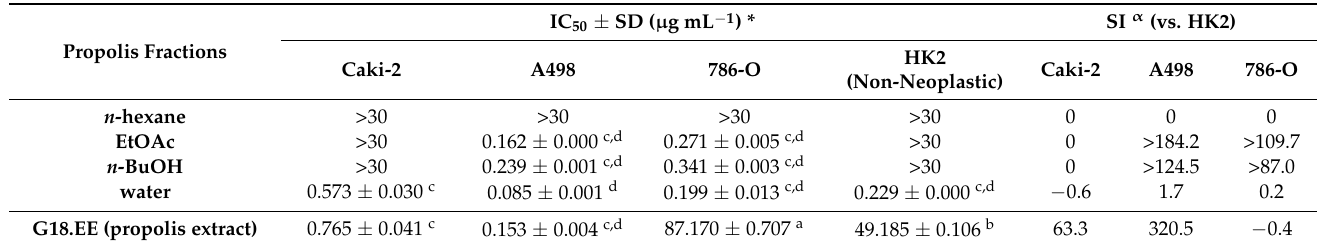
Table 1. IC 50 values and respective selectivity indexes of G18.EE and their fractions against RCC cells (72 h